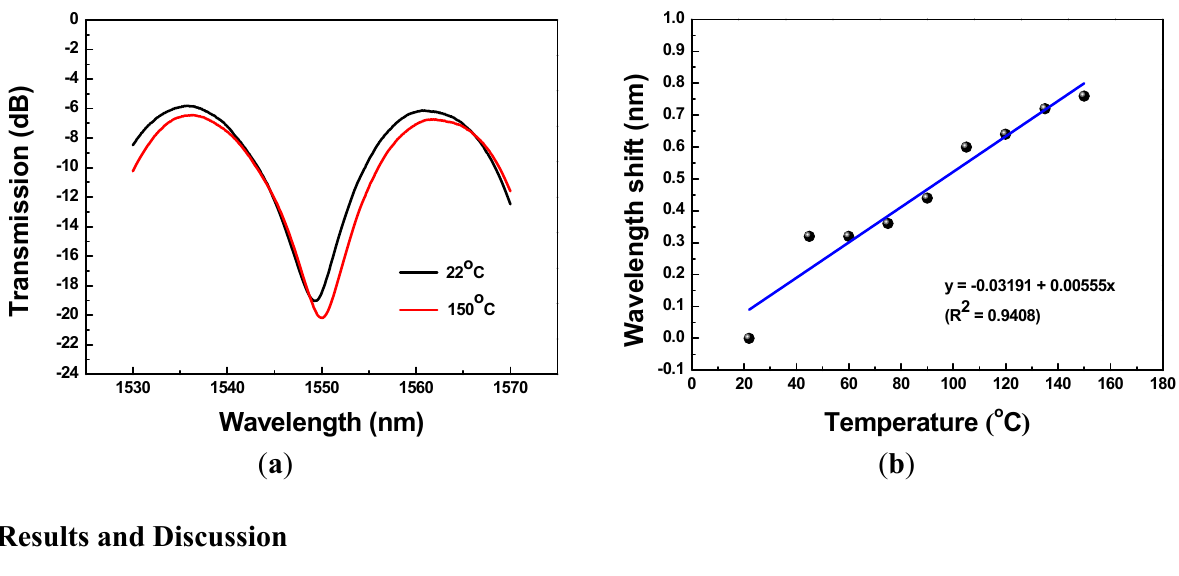
Figure 4. ( a ) The transmission spectra of a 2.67-cm PCF interferometers when heated from 22 °C to 150 °C; ( b ) The relationship between wavelength and temperature for